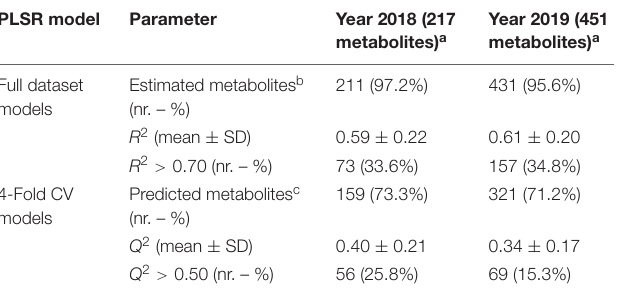
TABLE 3 | Summary of hyperspectral-based partial least squares regression (PLSR) models for estimation (full dataset) and prediction (4-fold CV) of leaf metabolite values in the 22 cotton accessions under both well-watered and water-limited conditions in 2018 and